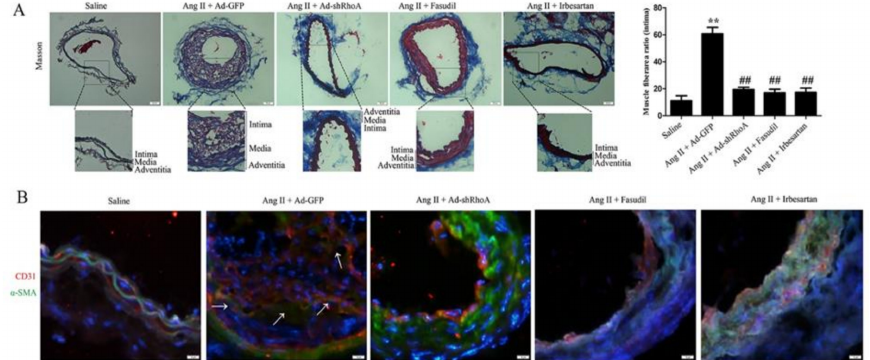
Figure 9. The effects of RhoA / ROCK pathway suppression or AT1 receptor inhibition on VSMC migration in Ang II-infused mice. Ang II was subcutaneously infused at a rate of 1000 ng / kg / min using the Alzet Model 1002 osmotic minipump. The group infused with normal saline was used as the control. The right common carotid arteries of mice were injected and incubated with 1 × 10 10 pfu virus solution specific for RhoA knockdown for 20 min. The AT1 receptor inhibitor Irbesartan (50 mg / kg / d) and ROCK inhibitor fasudil (30 mg / kg / d) were added to drinking water for consumption by mice. ( A ) Masson’s trichrome staining of carotid arteries 14 days after Ang II infusion. Masson’s trichrome staining shows the collagen fibers (blue) and muscle fibers (red). We marked the location of the intima, media, and adventitia. Histogram shows the ratio of muscle fiber area in the intima. The scar bar is 50 µ m. ** p < 0.01 vs. the saline-infused group; ## p < 0.01 vs. the model group (Ang II infusion + Ad-GFP virus) ( n = 10). ( B ) Immunofluorescence assay for α -SMA (green) and CD31 (red) as double staining (merge). Nuclei were stained with DAPI (blue). White arrows display that Ang II promotes the expression of α -SMA in the neointima, while α -SMA expression remains in the media in the control and other groups. The scar bar is 20 µ